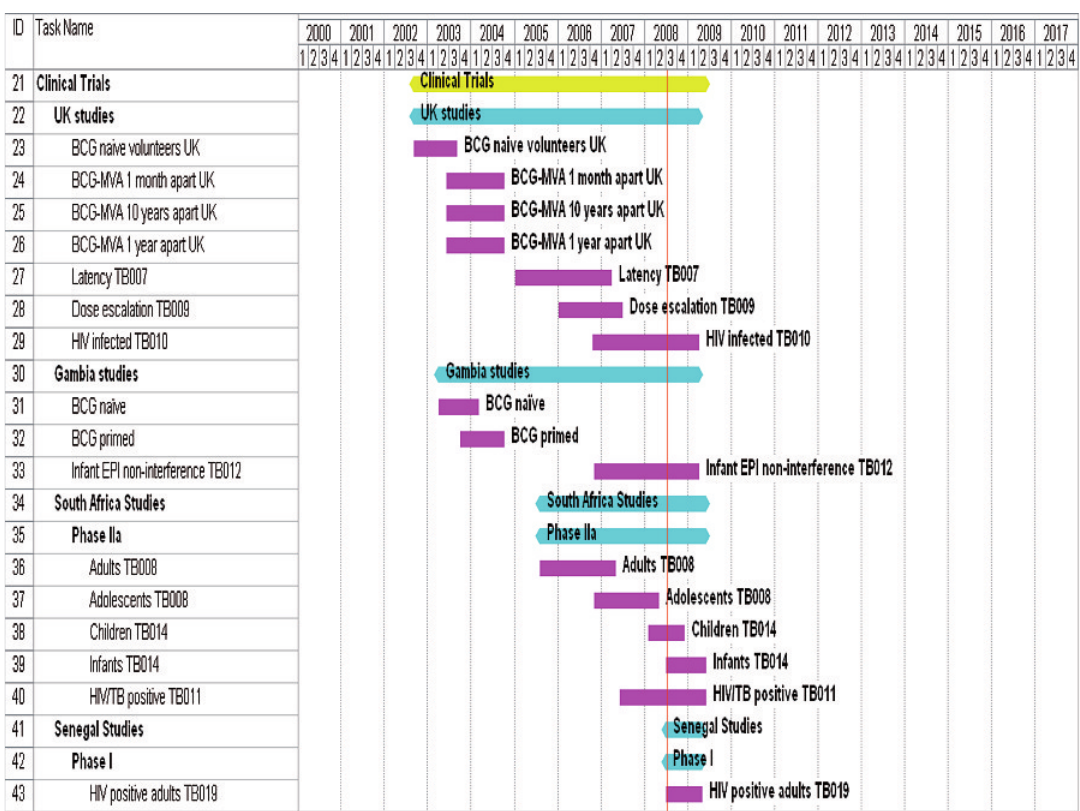
Figure 1 Gantt chart sum- marising the clinical trials conducted with MVA85A since